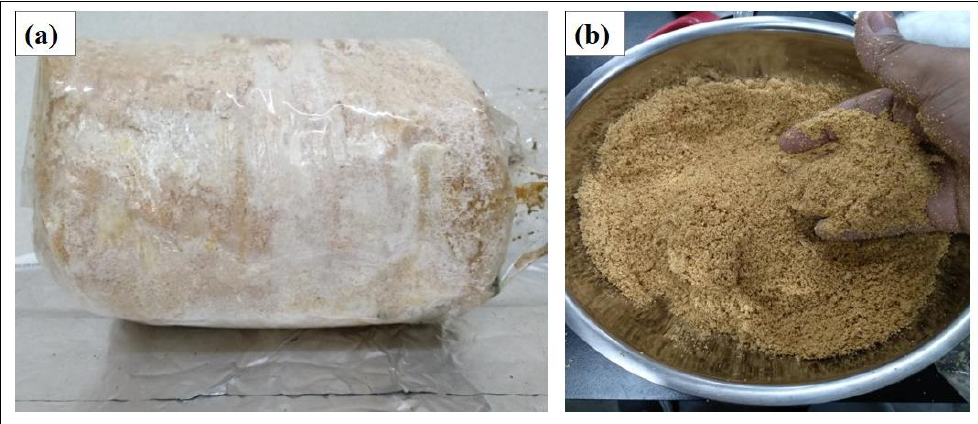
Figure 1. ( a ) Appearance of spent mushroom substrate (SMS) fiber block and ( b ) SMS fiber sample disintegration process.